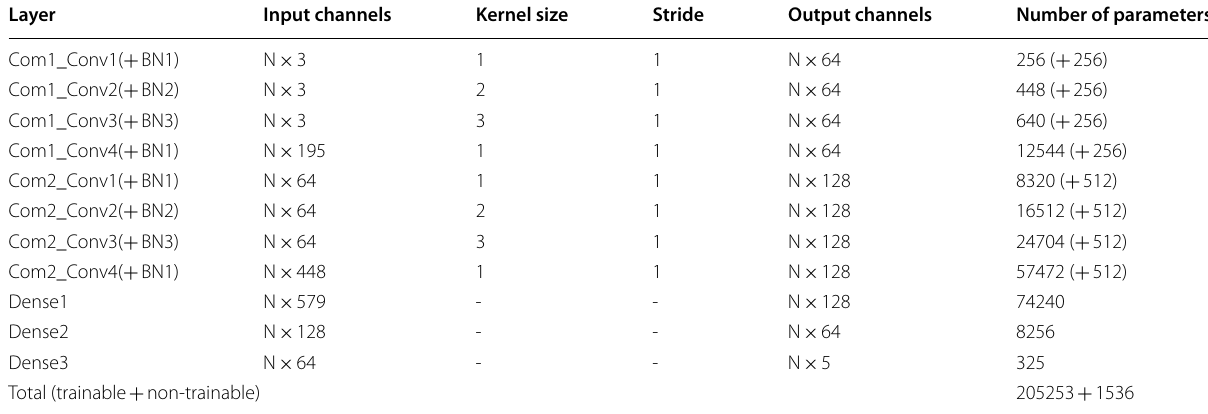
Table 2 Parameters in Gear-PCNet